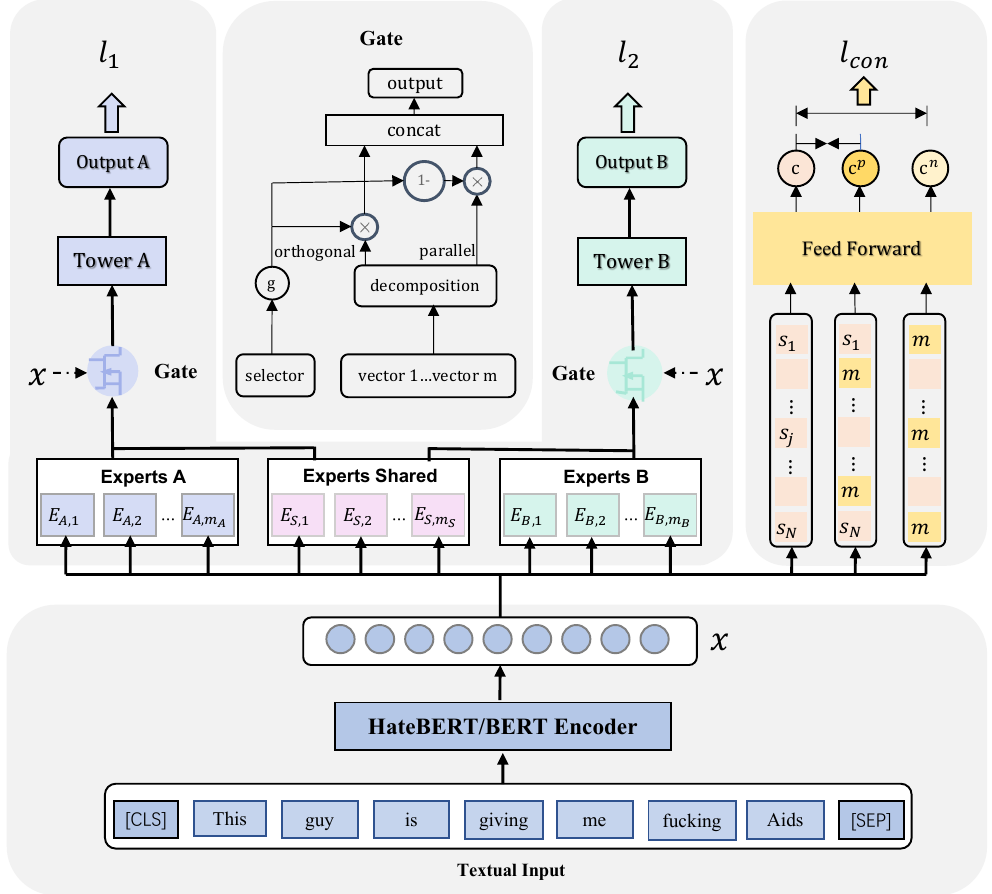
Figure 2. The overall architecture of our proposed Keyword-enhanced Multi-expert Framework for Hate Speech Detection